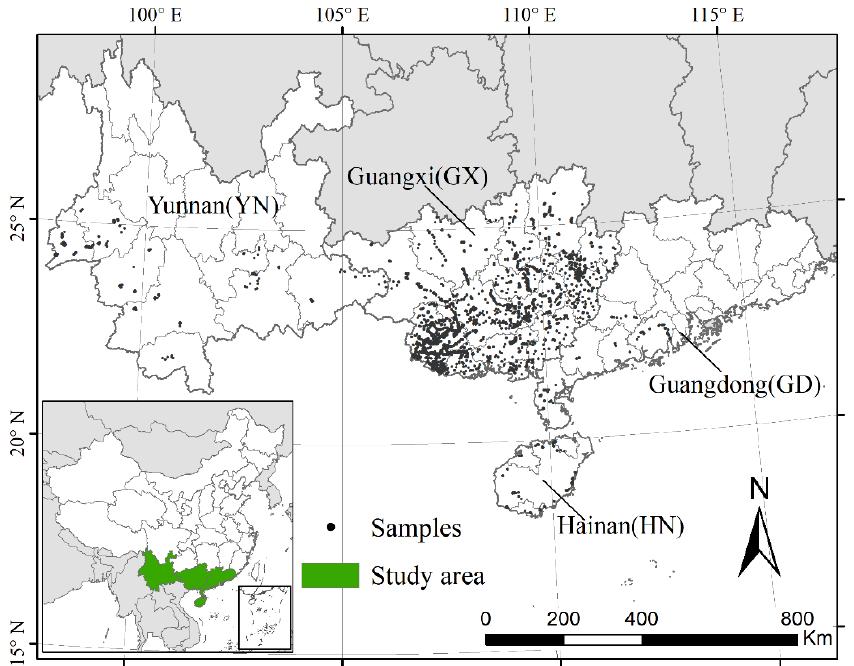
Figure 1. The study area included four provinces in the south of China. The solid dots represent the sample data used for calibration and validation derived from field surveys and Google Earth images for the year 2019.